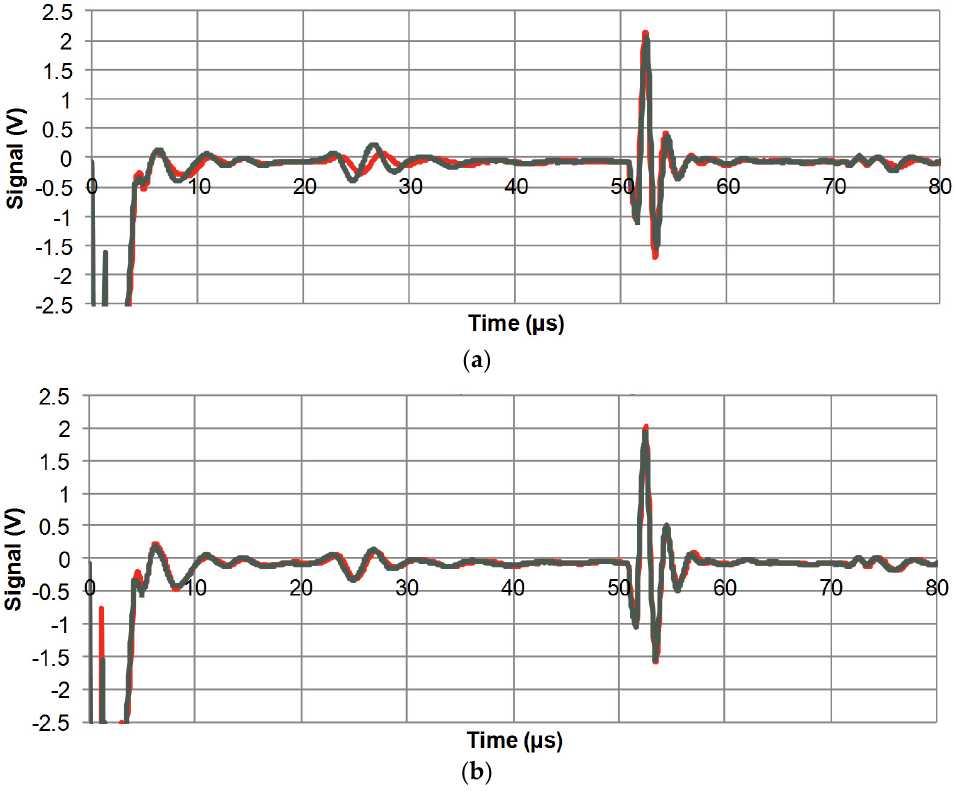
Figure 2. Pulse ‐ echo response for bulk transducers (pulse voltage 100 V, gain − 10 dB). ( a ) Two dry Figure 2. Pulse-echo response for bulk transducers (pulse voltage 100 V, gain ´ 10 dB). ( a ) Two dry piezoceramic elements; ( b ) Two oil ‐ saturated transducers. piezoceramic elements; ( b ) Two oil-saturated